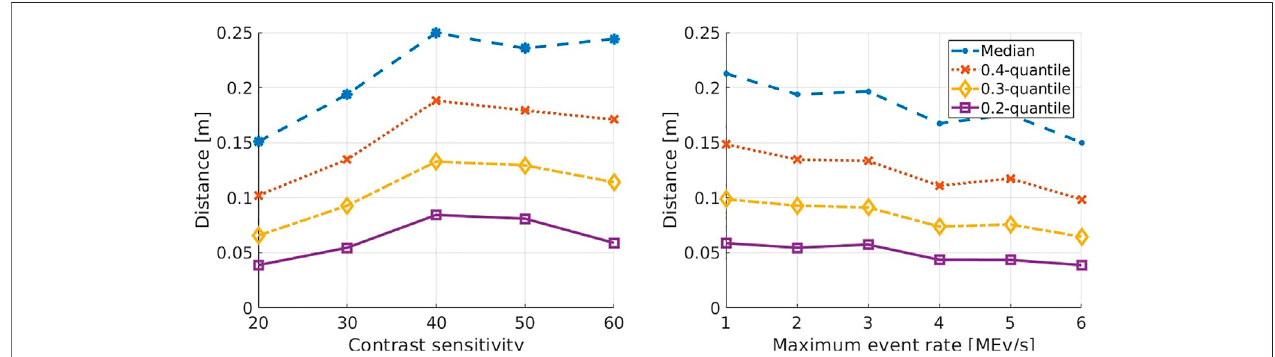
FIGURE6| Thegraphsshowhowcertaincameraparametersmayin fl uencethemeasureddistancesbetweenthereconstructedpointsandtheclosestonceofthe point cloud. The distances are plotted for different contrast sensitivities on the left and for over the maximum event rate on the right. Each plot shows four lines for the median at 0.4, 0.3 and 0.2 quantiles respectively.